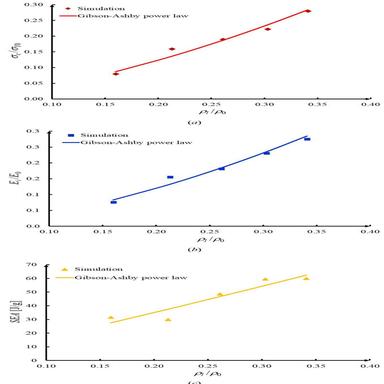
Gibson-Ashby power law fitting the numerical results: (a) relative collapse strength; (b) relative elastic modulus; (c) specific energy absorption.